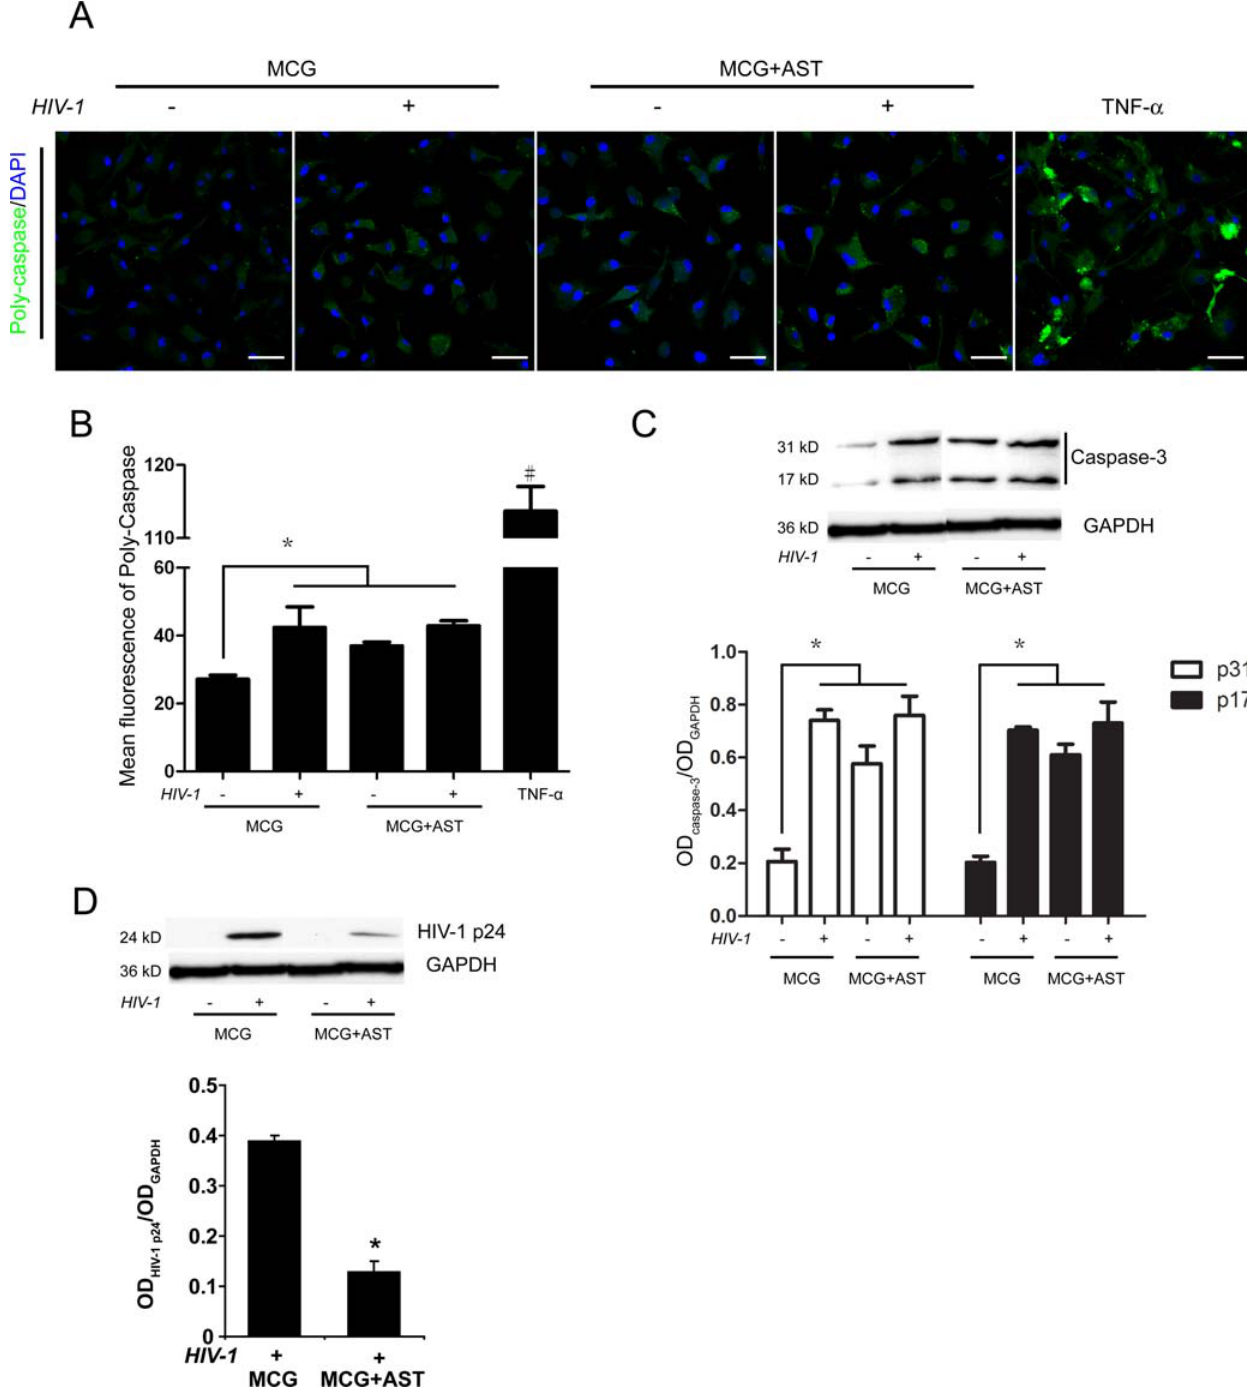
Figure 5. Caspase in HIV-1/VSV microglial infections. Uninfected or HIV-1/VSV infected microglia were cultured for 24 h in the absence (MCG) or presence of astrocytes (MCG + AST), Uninfected microglia cultured in the presence of 20 m g/ml TNF- a for 6 hours served as an activated microglia control. (A) Microglia were treated with a fluorescent-labeled inhibitor of caspases (FLICA; Immunochemistry Technologies, Bloomington, MN) to detect poly-caspases. Scale bar, 20 m m; original magnification, 6 63. (B) Quantification of poly-caspase expression as detected with FLICA was achieved by fluorescence microscopy and digital image analyses using Image-Pro Plus version 5.1 software (Media Cybernetics, Inc.) to calculate the ratio of overall fluorescence due to FLICA staining to that obtained by DAPI stained nuclei. Differences in mean poly-caspase fluorescence 6 SEM for n=5 determinations/group was assessed by one-way ANOVA and Tukey’s post-hoc tests for multiple comparisons. *p , 0.05, significant compared with uninfected single cultured microglia. # p , 0.05, significant compared with other 4 groups. (C) Western blot analysis of caspase-3 p 31 and p 17 levels showed trends consistent with FLICA analysis. Densitometric analysis of p 31 and p 17 levels were normalized to GAPDH levels and mean 6 SEM were determined for n=5 determinations. Differences between means were determined by one way ANOVA and Tukey’s post-hoc test for multiple comparisons where *p , 0.05. (D) Western blot analysis showing HIV-1 p24 expression in cultures of infected microglia alone (MCG) or co-cultures